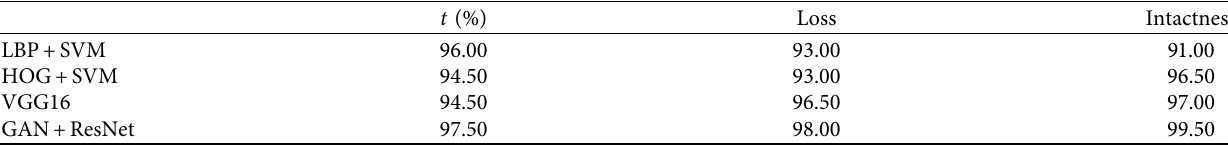
Table 8: Recall rates of different methods.